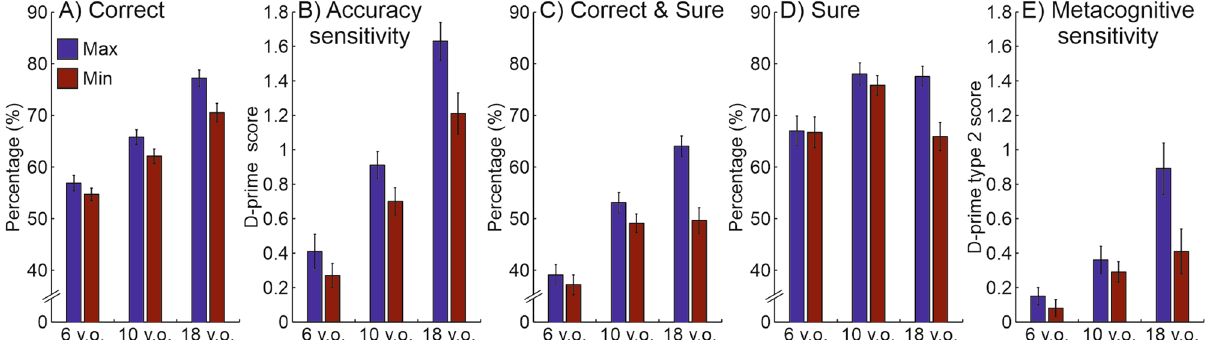
Figure 2. Bar graphs displaying mean performance as a function of age groups and saliency conditions. Mean values of: ( A ) correct responses irrespective of confidence, ( B ) accuracy sensitivity, ( C ) correct and sure responses, ( D ) sure responses irrespective of accuracy, ( E ) metacognitive sensitivity. In all bar graphs, the error bars represent the standard error of the